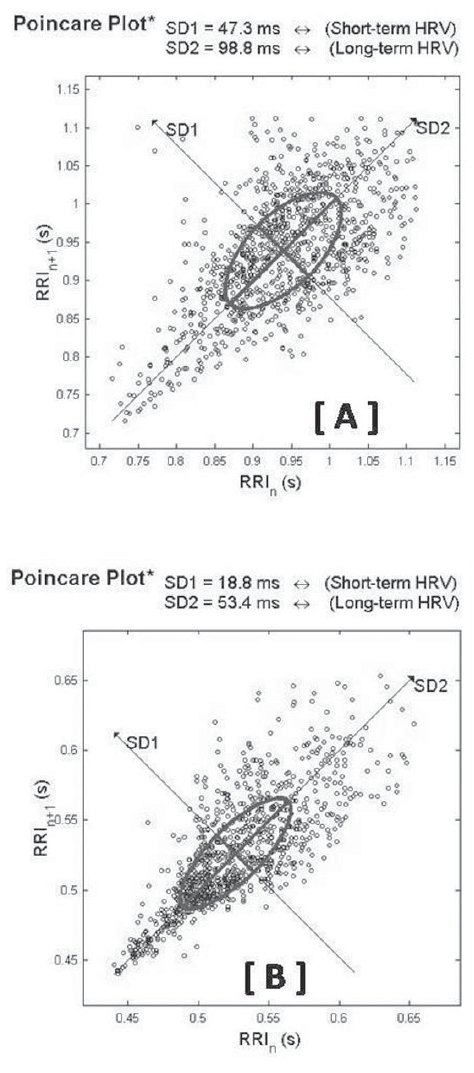
Fig. 2 – Gráfico de Poincaré de um adulto jovem normal (A) e de um recém-nascido normal (B). A dispersão tanto de curto (SD1) quanto de longo prazo (SD2) no painel B está menor do que no painel